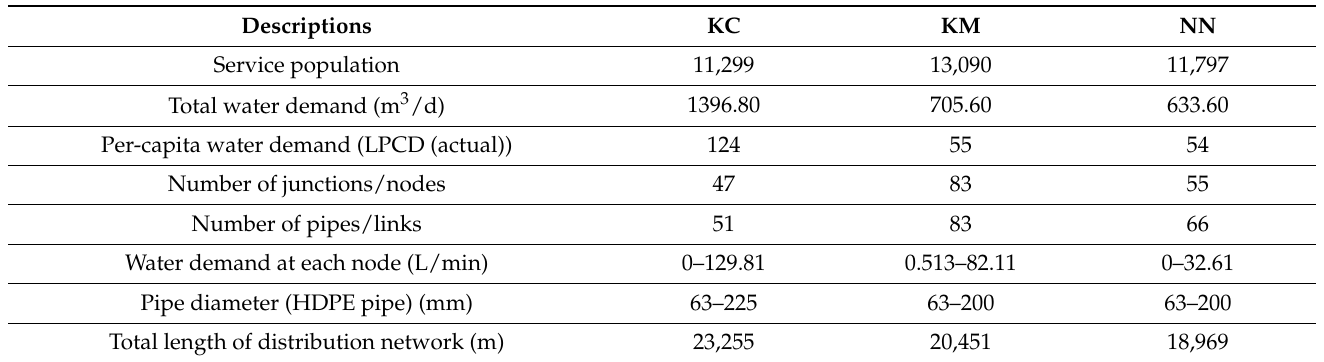
Figure A4. Alternative drinking water sources in the study area: ( a ) piped water; ( b ) unprotected dug well; ( c ) rainwater; and ( d ) bottled water. Table A1. Demand calculations for EPANET analysis for the study areas [28].